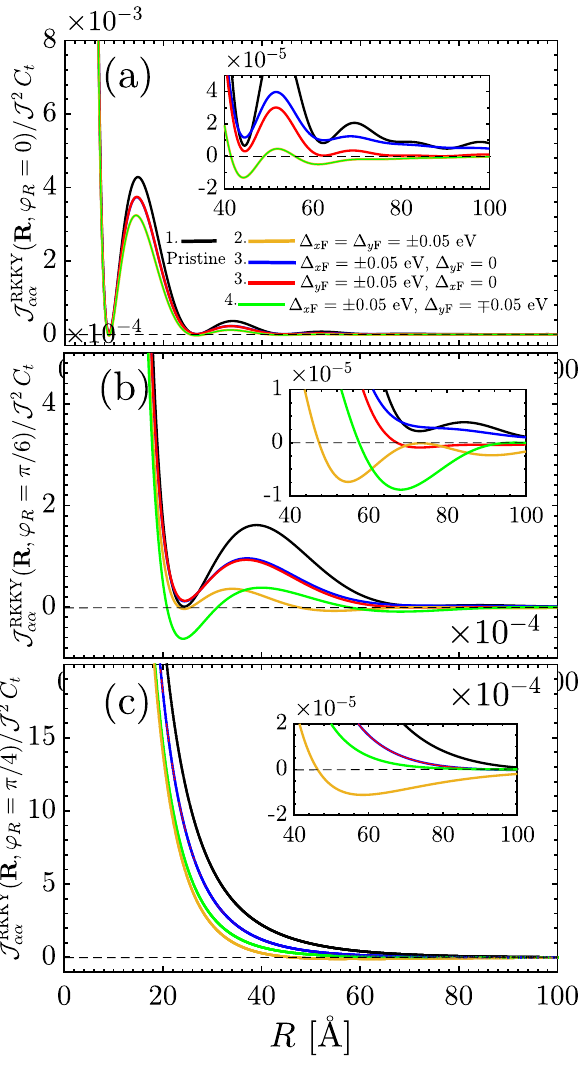
Figure 6. The behavior of the RKKY interaction J RKKY αα ( R , ϕ R )/ J 2 C t as a function of R for different ferroelectric distortion potentials at ( a ) ϕ R